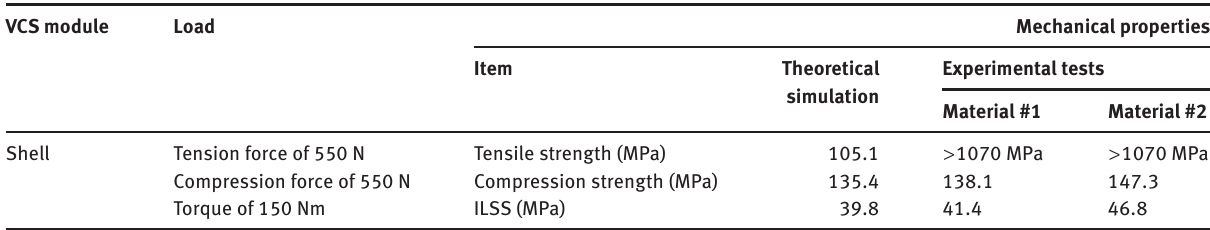
Table 1: Corresponding values of the mechanical properties from theoretical simulation and experimental investigation. VCS